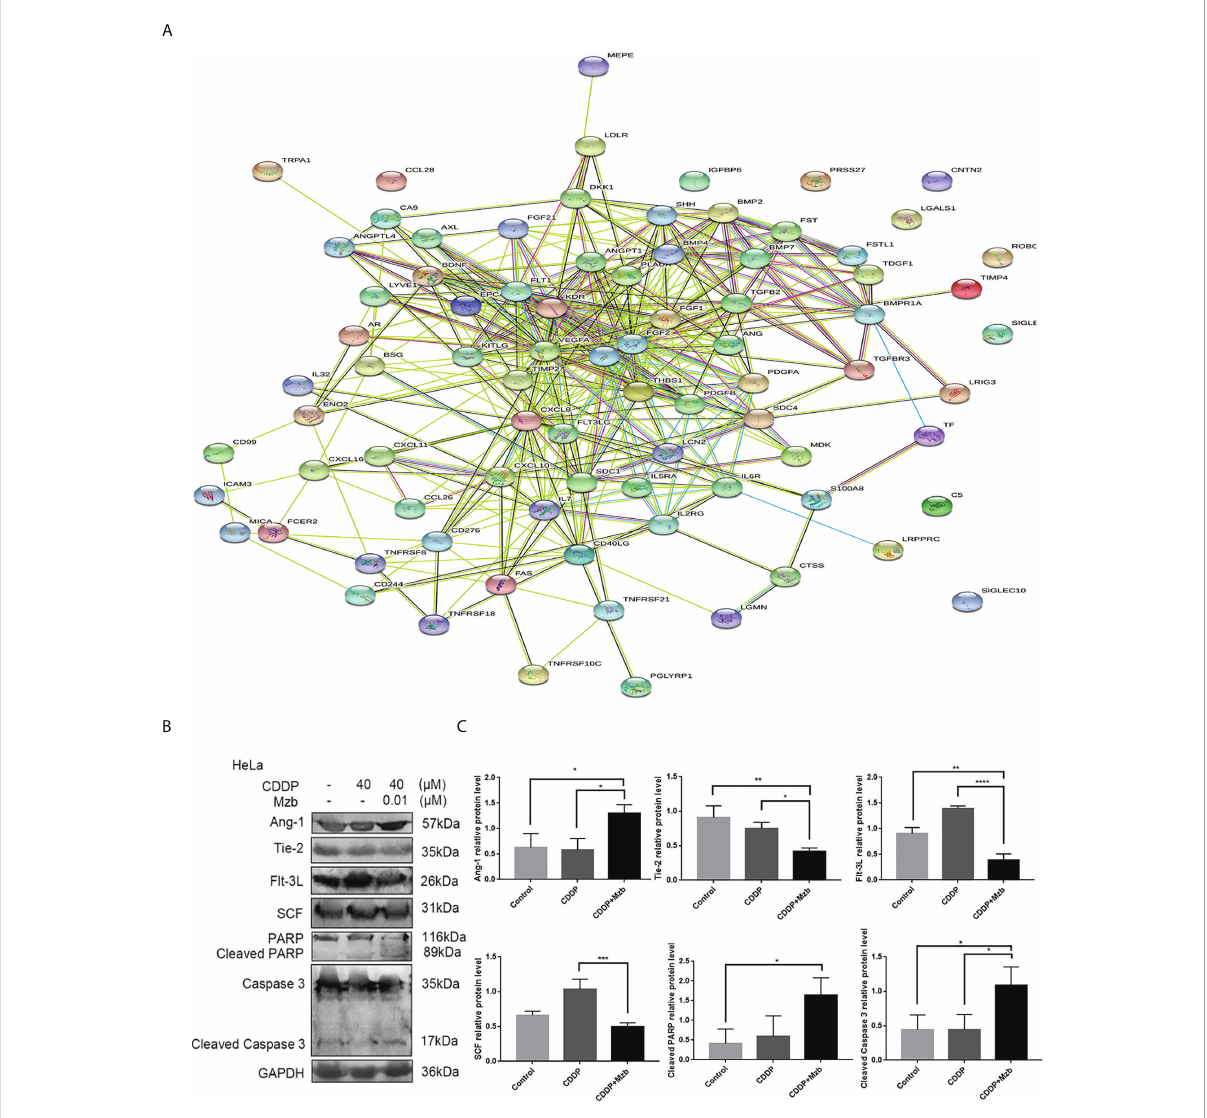
FIGURE 5 Cytokine array showing that marizomib boosts the cytotoxic effect of CDDP on cervical cancer cells by upregulating Ang-1 expression and downregulating Flt-3L, SCF and Tie-2 expression. The cervical cancer cell line HeLa was treated with CDDP (40 m M) alone or in combination with marizomib (0.01 m M) for 48 h (A) The cell supernatant was collected to make a cytokine antibody chip, and the PPI map was obtained. (B) The whole cell lysate was then run on SDS − PAGE and western blotted with antibodies against Ang-1, Tie-2, Flt-3L, SCF, PARP, and caspase 3. GAPDH was used as a loading control. (C) The gray value was quanti fi ed and plotted. *P<0.05, **P ≤ 0.01, ***P ≤ 0.001, ****P ≤ 0.0001, by ANOVA (Dunnett ’ s multiple comparison